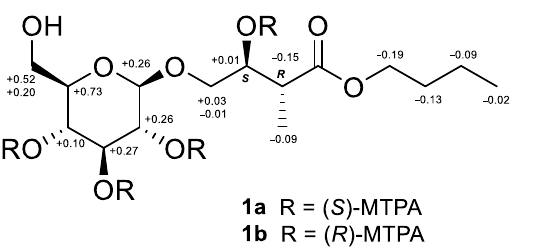
Compound 2 , tuliposide I, gave the molecular formula, C 15 H 28 O 8 , as established by HRESIMS ( m / z 359.1686 [M + Na] + , calcd for 359.1682). The 1D NMR spectra of 2 were also similar to those of 1 , except the fact that the chemical shifts of the methylene signal δ H 1.65 (sext, J = 7.0 Hz) and 1.96 (sext, J = 7.0 Hz)/ δ C 34.6 were identified instead of one methine at C-3 of 1 (Table 1). On the basis of the COSY and HMBC data (Figure 2), compound 2 was postulated to be composed of an isoprenoid, one glucose, and the n -butyl groups as well. The HMBC 3 J correlations of H 2 - 1″ ( δ 4.04, 2H, t, J = 7.5 Hz/ δ C 65.4) with C-1 ( δ 178.5) and H-1 ′ ( δ 4.19, d, J = 8.0 Hz/ δ C 104.4 ) with C-4 ( δ 68.4) suggested that the n -butyl group and one β -glucose moiety [8] were connected at C-1 and C-4, respectively (Figure 2). Key HMBC and COSY correlations are shown in Figure 2. The R -configuration of H 3 -5 at C-2 of 2 was determined by acid hydrolysis of 2 to offer corresponding tulipalin compound, 3-methyldihydrofuran-2(3 H )-one (Figure S28) [8] with a positive optical rotation value ([ α ] 23D +18.7, CH 2 Cl 2 ) ( R : [ α ] 25D +14.7, CHCl 3 ) [10]. The structure of compound 2 was iden- tified as butyl 4- β - D -glycopyranosyl-( R )-2-methylbutanoate. The molecular formula of 3 was deduced as C 11 H 20 O 8 due to the appearance of a [M + Na] + ion at m / z 303.1049 (calcd for 303.1050) in the HRESIMS. Eleven carbon signals, including one methyl ( δ 17.6), three methylenes ( δ 34.7, 62.8, and 68.6), six methines ( δ 37.6, 71.6, 75.1, 77.9, 78.0, and 104.4), and one quaternary carbon ( δ 180.6), were observed in the 1D NMR spectra of 3 (Table 1). The quaternary carbon was identified as a carbonyl carbon on the basis of the carbon chemical shift at δ 180.6. Furthermore, compound 3 showed similar spectroscopic data to that of 2 , except the n -butyl signals. In the HMBC spectrum (Figure S15), the anomeric proton at δ 4.23 (d, J = 8.0 Hz) exhibited 3 J interaction with C-4 ( δ 68.6) led to the β -glucose located at C-4. Key HMBC and COSY connections are shown in Figure 2. Compound 3 was not isolated in a sufficient quantity to determine the absolute configuration at C-2. Finally, tuliposide J ( 3 ), 4- β - D -glycopyranosyl-( R )-2- methylbutanoic acid, was identified because of abovementioned structural elucidations of 1 and 2 in this study. Compounds 1 – 3 are tuliposides, a kind of specialized products consisting of 4-hy- droxy-2-methylenebutanoic acid (HMBA) and/or (3 S )-3,4-dihydroxy-2-methylenebu- tanoic acid (DHMBA) groups acylated at C-1 and/or C-6 positions of a β - D -glucose (Glc) mainly found in the genus Tulipa [8,11]. So far, tuliposide analogues, including 1-tulipo- side A, 6-tuliposide A, 1-tuliposide B, 6-tuliposide B, and tuliposides D – G, have been iso- lated from Tulipa [8,11]. However, the structure of tuliposide C has not been reported and could be missing in previous literatures [11]. Tulipalins, such as tulipalin A and ( – )-tuli- palin B, are the aglycone portions of tuliposides, which spontaneously lactonizes after re- leasing HMBA and/or DHMBA groups by tuliposide-converting enzymes [8,11]. In this study, compounds 1 – 3 named as tuliposides H – J belong to tuliposides, but their double bonds at C-2 were reduced and the β - D -glucose groups were attached to C-4 (oxymeth- ylene), instead of C-1 ( O -acyl functionality) in HMBA or DHMBA (Figure 1). Additionally, compound 10 (2 S ,3 S ) is tulipalin but could not be metabolized from 1 (2 R ,3 S ) due to the different configuration at C-2. The possible biosyntheses of tuliposides 1 – 3 are shown in Figure S29 [8,11].